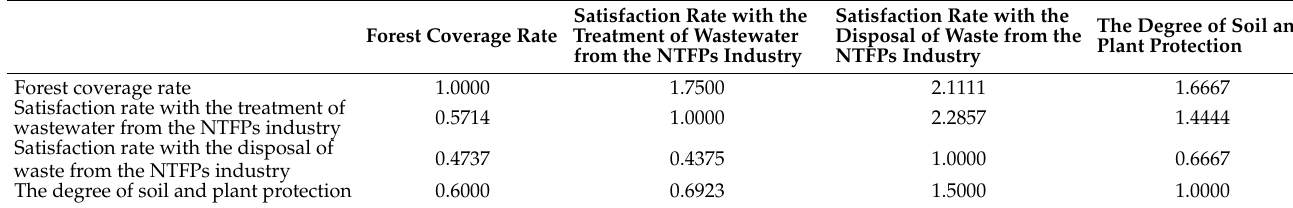
Table A7. C3–D: Judgement matrix of the ecological protection.